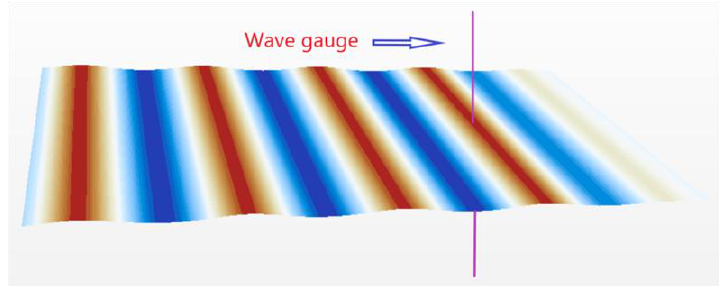
Figure 6. Installation position of wave gauge.